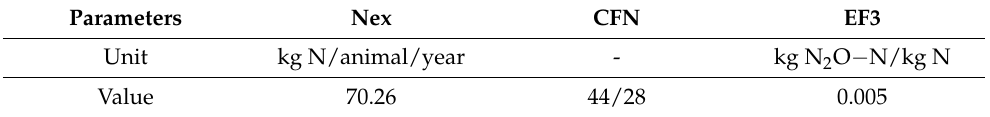
Table 2. Parameters and factors of N 2 O emissions from cow manure (source [19]).